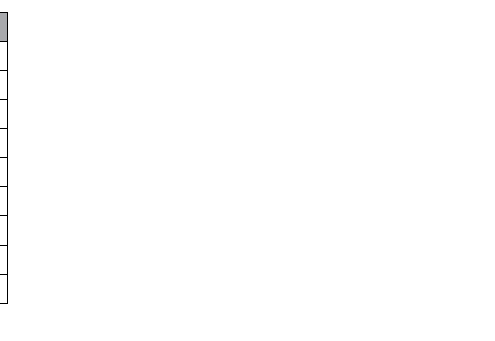
Table 1. Histological types of 1235 thyroid